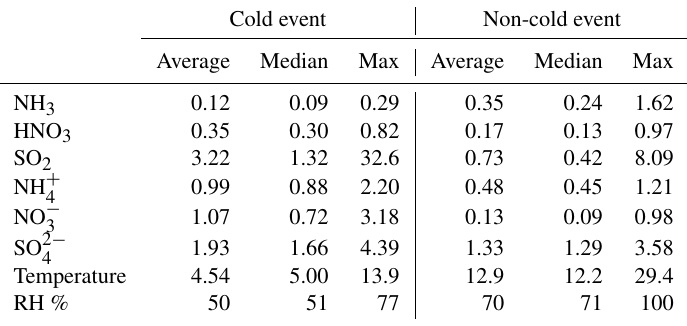
Table 3. Summary of concentrations (µgm − 3 ) of aerosol and precursor gases during and outside of cold air mass periods. Cold